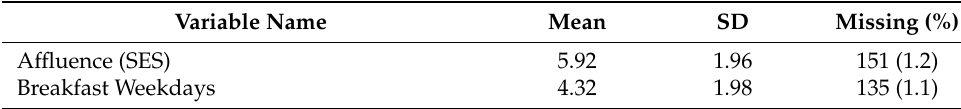
Table 1. Descriptive statistics of